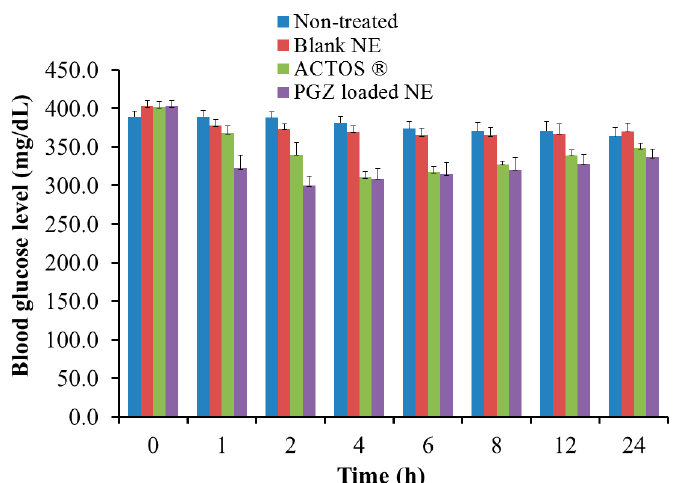
Figure 10. Profile representing the blood glucose level of rats induced with diabetes and treated with PGZ-loaded NE and blank NE compared to ACTOS ® formulation and non-treated rats.